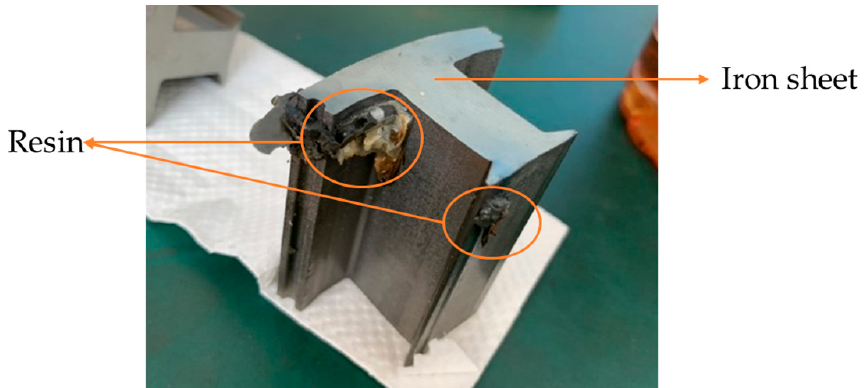
Figure 17. Schematic diagram of bumps caused by resin over-flow.